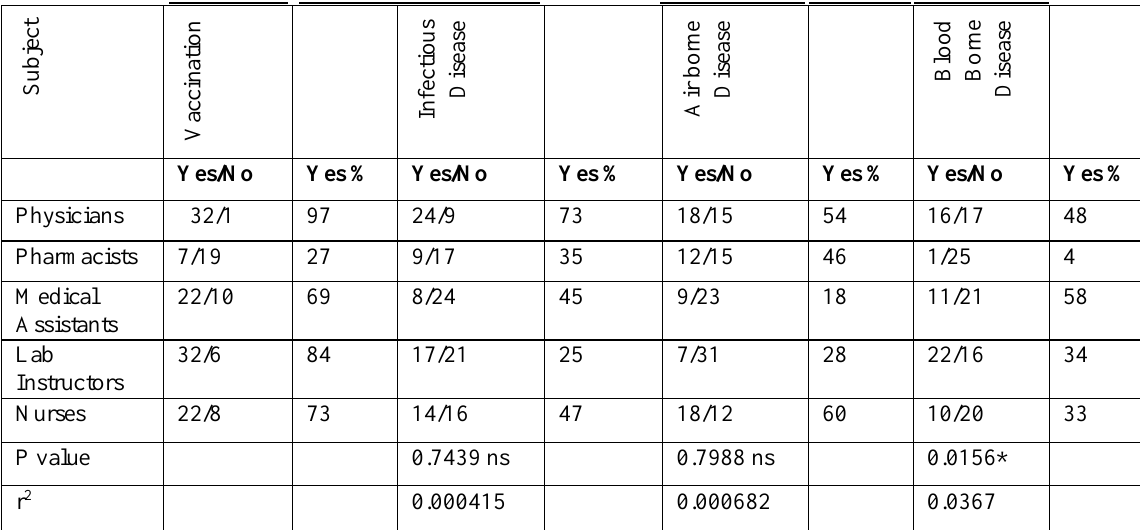
Table 5. Correlation between Vaccination and Communicable Diseases.